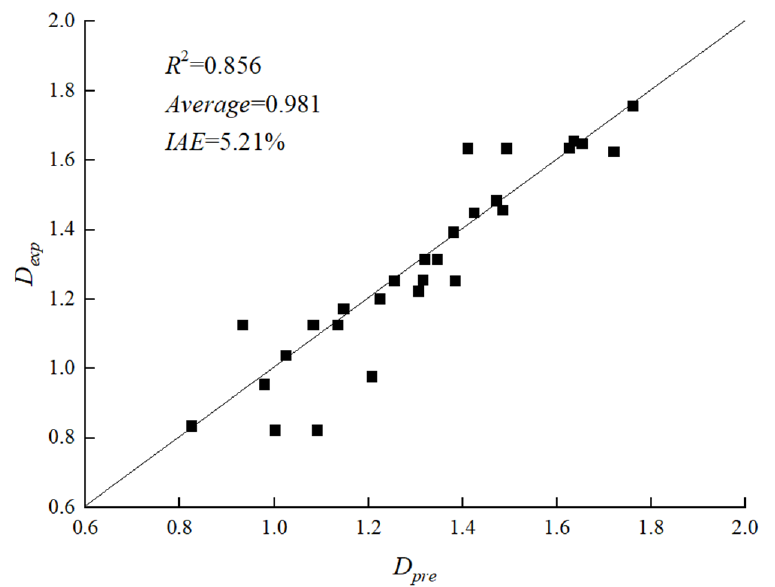
Figure 10. Comparison of experimental and predicted values of fractal dimension.